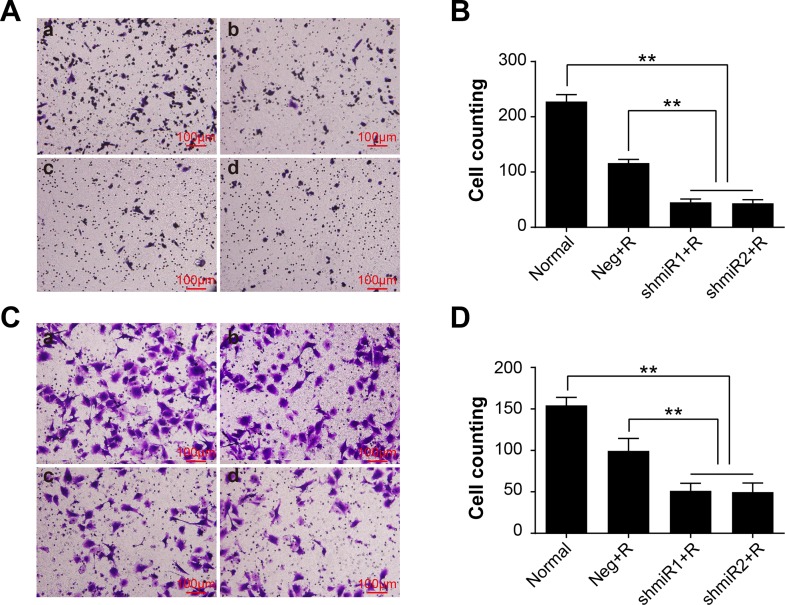
Transwell invasion assay in different treatment groups.(A) Representative images of the invasion assay in SK-BR-3 cells. (a) Normal; (b) Neg+R; (c) shmiR1+R; (d) shmiR2+R. (B) Comparisons of the cell counts in different groups of SK-BR-3 cells. (C) Representative images of the cell invasion assays in MDA-MB-231 cells. (a) Normal; (b) Neg+R; (c) shmiR1+R; (d) shmiR2+R. (D) Comparisons of the cell counts in different groups of MDA-MB-231 cells. ** P<0.01. Data was shown as the means ± SD from three independent experiments. The group definition is the same as Fig 1.